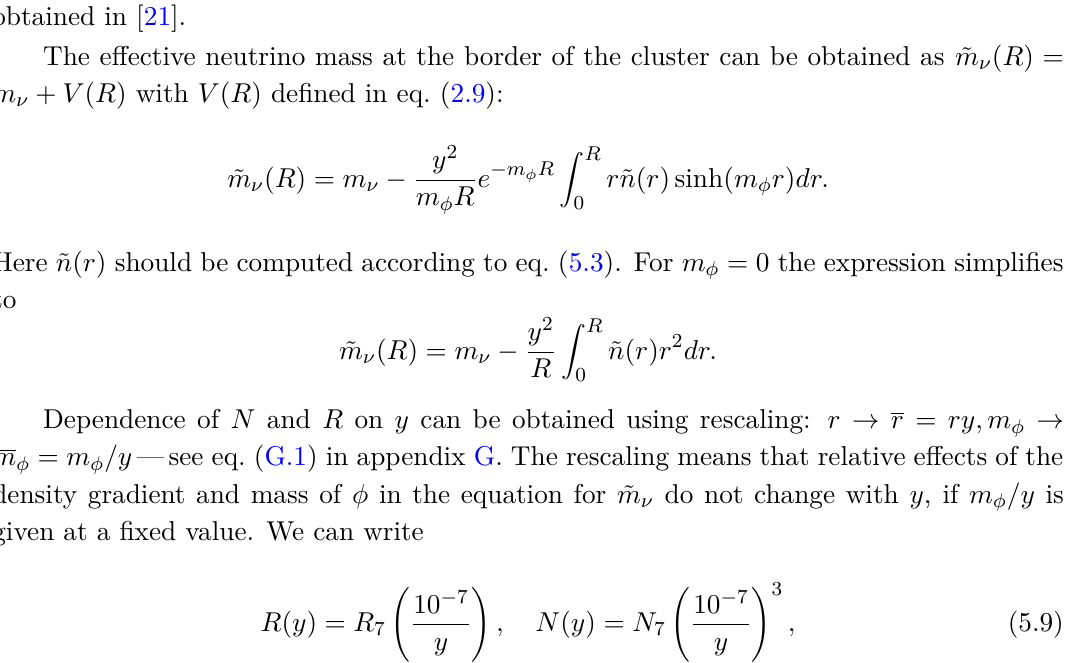
accurately computed using the non-relativistic approximation according to the difference between the dashed and solid curves in figure